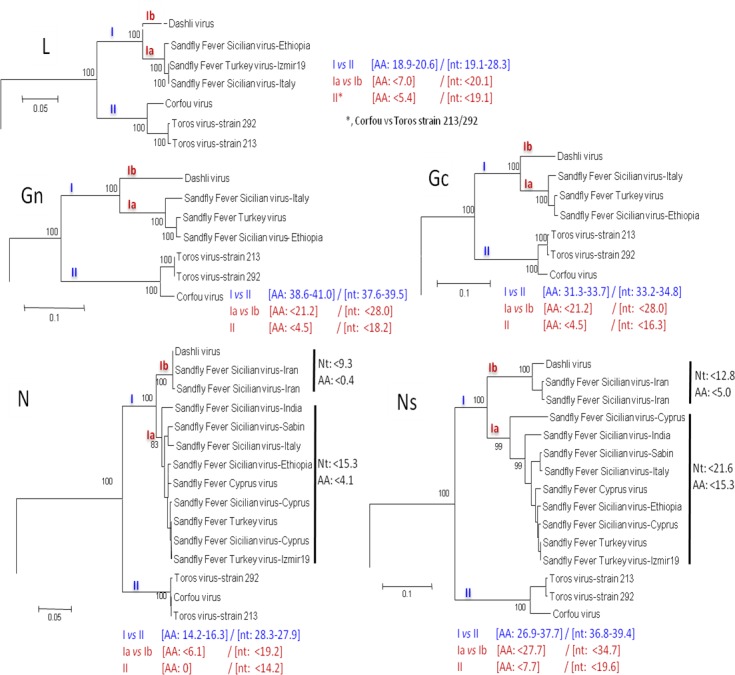
Phylogeny and proposed lineages and sublineages within the Sandfly fever Sicilian virus complex.